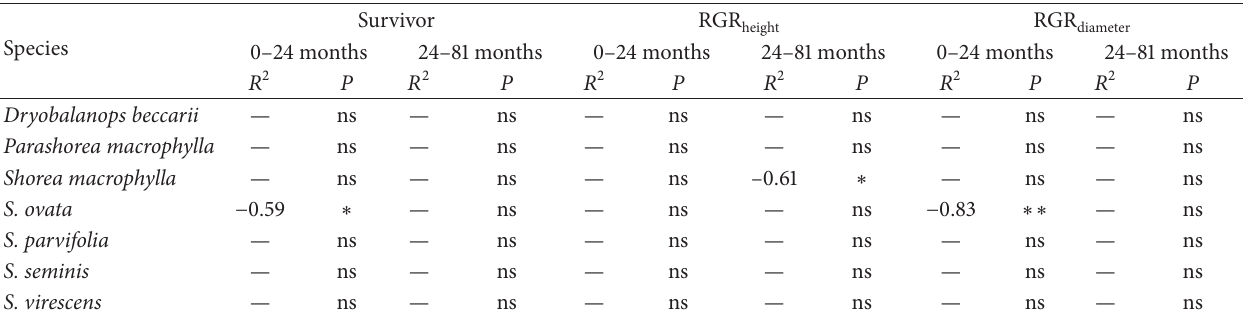
Table 4: Correlation between soil hardness (penetrometer counts at the depth of 0–20cm) and seedlings survivor, relative growth rate in ) and diameter (RGR ) during 0–24 months and 24–81 months in the secondary forest and logged forest. height (RGR height diameter